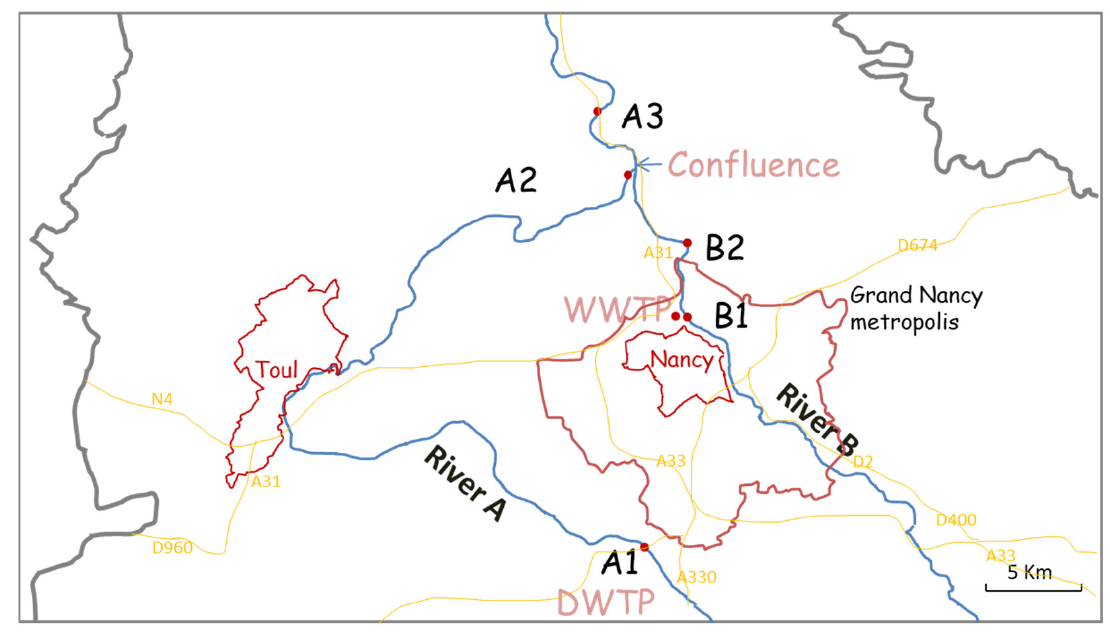
Figure 1. Map showing the location of the sampling sites (A1: Messein, A2: Pompey, B1: Malzéville, B2: Moulin Noir, and A3: Belleville) and the cities of Nancy and Toul, as well as Moselle River A and Meurthe River B. Epinal city is located upstream 52.2 km from A1 (not shown on the map). The map indicates also the positions of the confluence of the two rivers, the wastewater treatment plant (WWTP), and the catchment for drinking-water treatment plant (DWTP) (A1). The main roads are in yellow lines.